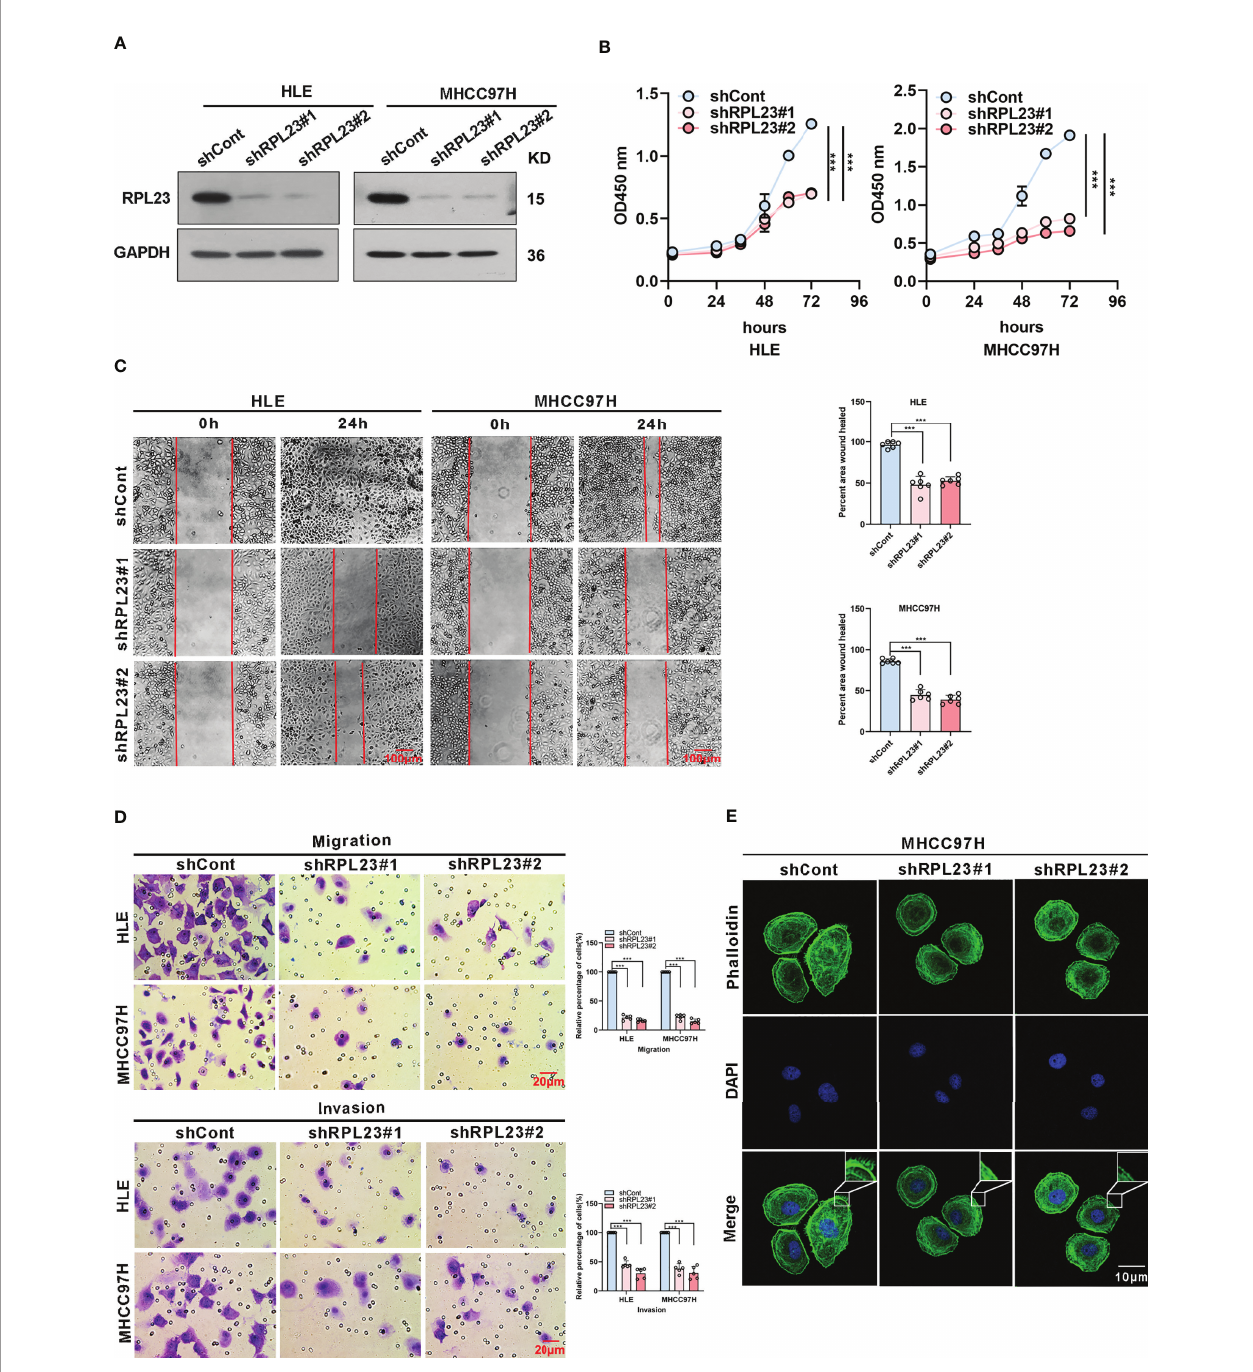
FIGURE 3 | Knockdown of RPL23 signi fi cantly suppressed HCC cell proliferation, invasion and migration in vitro . (A) Western blotting was used to access RPL23 expression after transfected with negative control (shCont) or shRNA (shRPL23#1 and shRPL23#2) in HLE and MHCC97H cells. GAPDH was used as the internal quantitative control. (B) CCK-8 assay showed that RPL23 knockdown suppressed HCC proliferation capacity. (C) Wound-healing assays were performed to determine the migratory abilities of RPL23-knockdown HCC cells in HLE and MHCC97H cells. The cells were counted from 6 images. (D) Cell migration and invasion as measured by transwell assays were inhibited by knockdown RPL23 in in HLE and MHCC97H cells. The cells were counted from 5 images. (E) Phalloidin (green color) was applied for cytoskeleton staining, while DAPI (blue color) was used to mark the nuclei in RPL23-depleted MHCC97H cells. Magni fi cation, 630×. Representative data are from at least three independent experiments. Data are shown as mean ± SD. ***P <